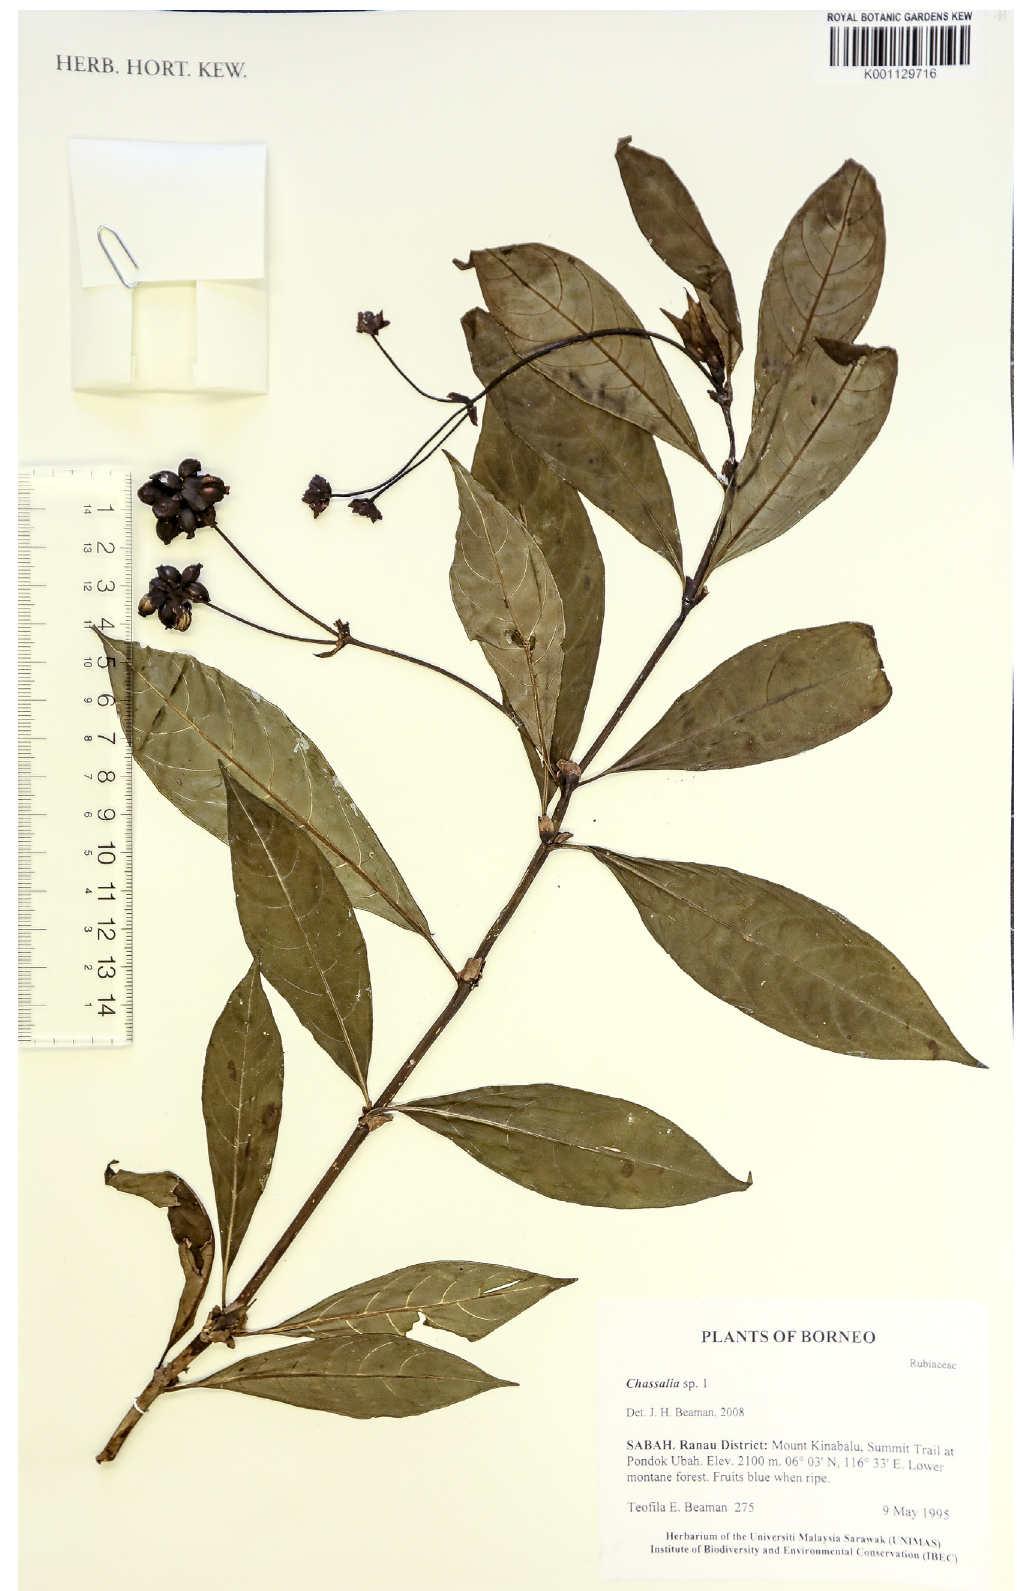
Fig. 21. Holotype of Chassalia longipes T.Y.Yu sp. nov. ( Teofila E. Beaman 275